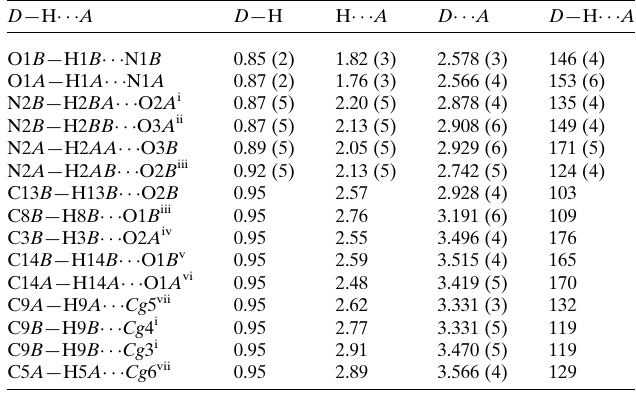
Table 1 Hydrogen-bond geometry (A˚ , (cid:2) ). Cg 3, Cg 4, Cg 5 and Cg 6 are the centroids of the C10 A –C15 A , N1 A /C7 A –C15 A , N1 B /C7 B –C10 B /C15 B and C1 B –C6 B rings, respectively.